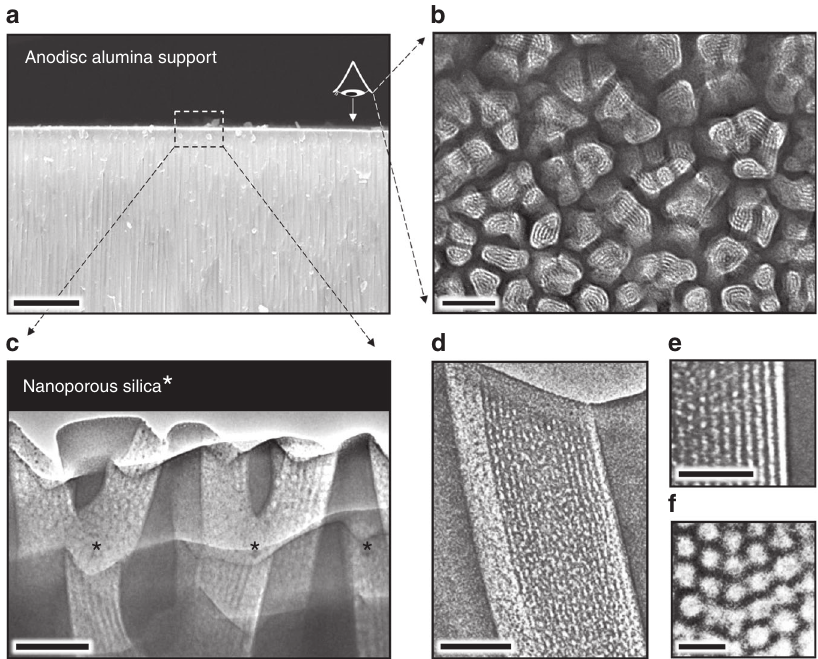
Fig. 3 Electron microscopy images of the membrane hierarchical macro-structure and nano-structure. a Cross-sectional SEM image of the Anodisc support showing oriented ~50-nm-wide pore channels near the top surface (scale bar: 5 μ m). b Plan-view TEM image of focused ion beam (FIB)-sectioned Anodisc surface showing complete fi lling of all Anodisc pore channels with ordered arrays of silica mesopores (scale bar: 100 nm). (Note: FIB sectioning served to etch the alumina leaving only the silica mesopore arrays. Silica mesopore arrays not perfectly aligned normal to imaging axis appear as stripe patterns). c Cross-sectional TEM image of the Anodisc surface showing oriented arrays of 8 nm diameter cylindrical mesopores fi lling the Anodisc pores (scale bar: 100 nm). d , e Higher magni fi cation cross-sectional TEM image showing oriented array of 8 nm diameter cylindrical mesopores fi lling a single Anodisc pore (scale bar d : 100 nm; scale bar e : 50 nm). f Plan-view TEM image of silica mesopore array at membrane surface showing hexagonal close packing of cylindrical mesopores (scale bar: 20